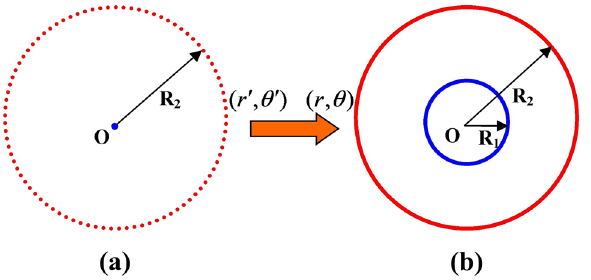
Figure 1. (color online) Coordinate transformation for an acoustic cloak. ( a ) original space, ( b ) transformed